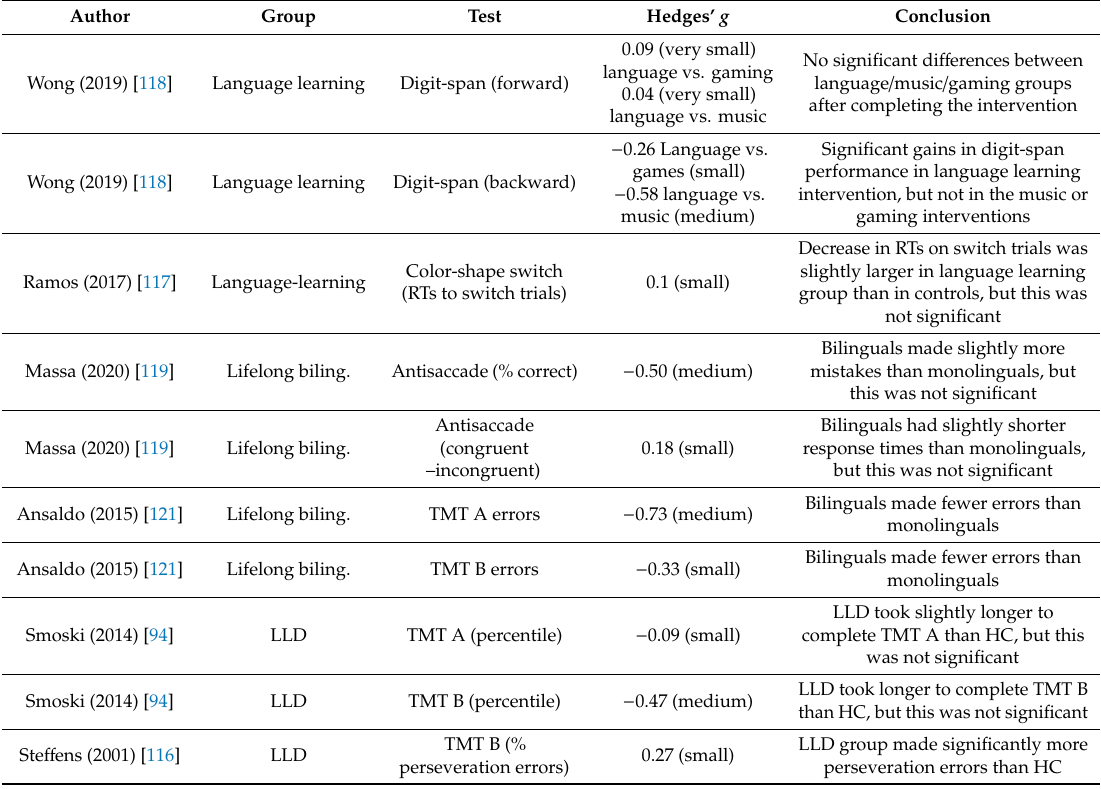
Table 4. E ff ect sizes of neuropsychological tasks that were used only once.